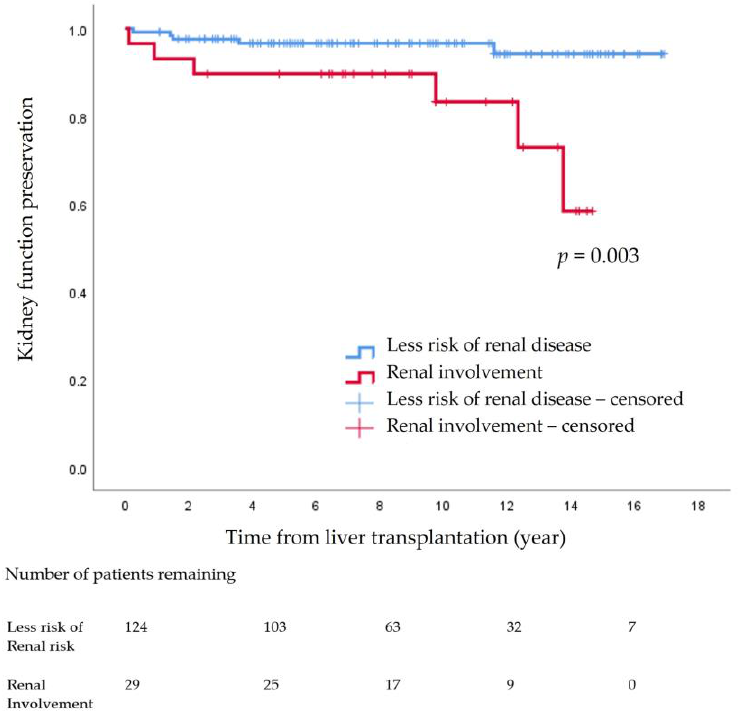
Figure 2. Kidney function preservation after pediatric liver transplantation. Table 3. Multivariable analysis of factors associated with stage 3 chronic kidney disease progression (n =